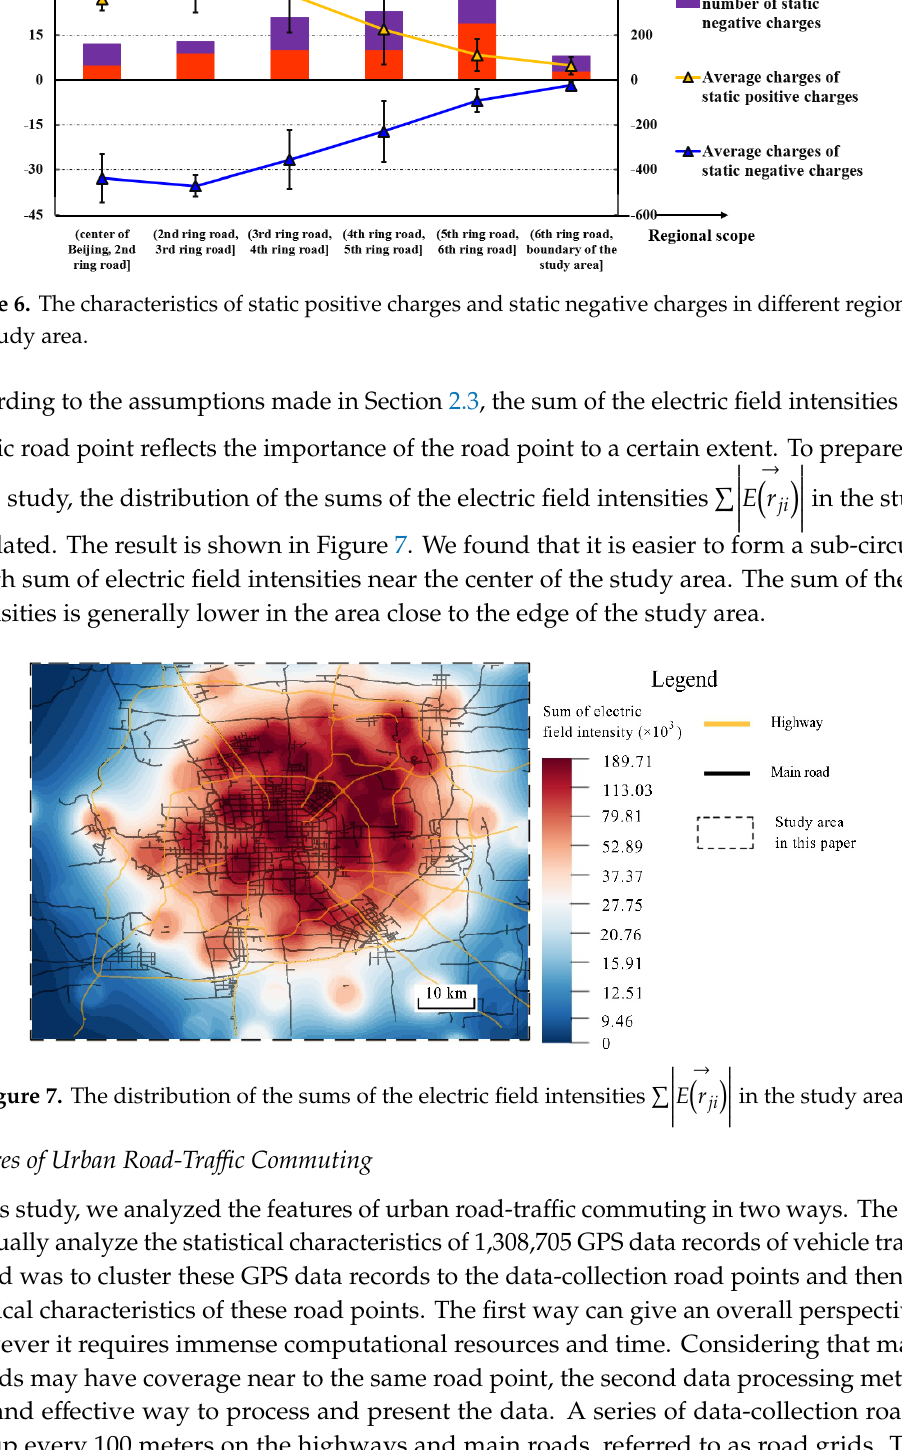
Figure 7. The distribution of the sums of the electric field intensities